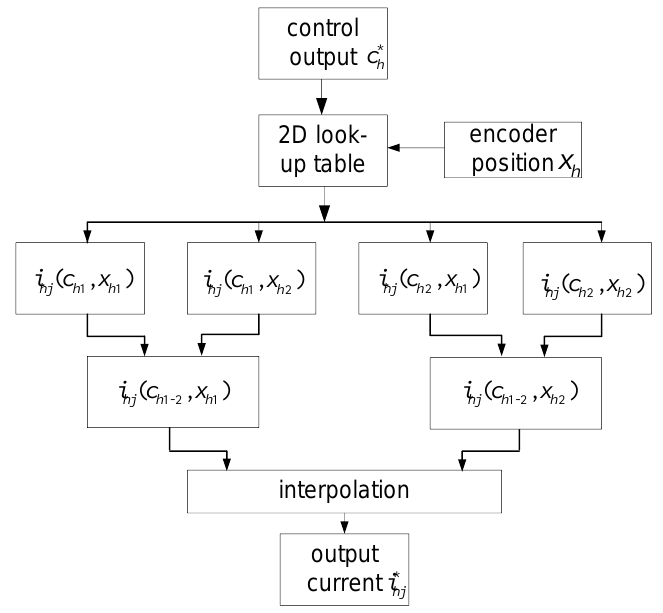
Figure 3. Flow chart of current command derivation by interpolation. 2D: two-dimensional.